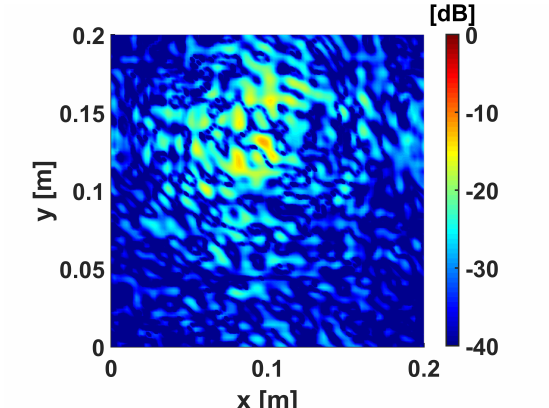
Figure 5. Amplitude ( a ) and angle ( b ) at the top of the wooden particleboard without a flaw. Evaluated with the re-radiation method for the frequency 50kHz, with d x = d y = 2 mm and a grid of the size 101 × 101 points.